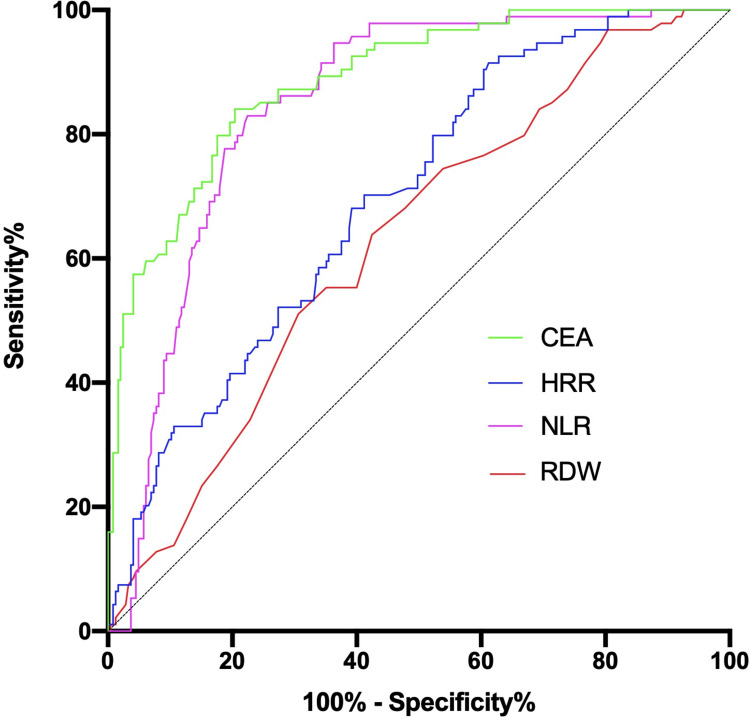
The ROC curves for RDW, NLR, HRR and CEA.Area under ROC curves were 0.629, 0.846, 0.696 and 0.887, respectively. P values were all <0.001. RDW red blood cell distribution width; NLR neutrophil-to-lymphocyte ratio; HRR hemoglobin-to-red blood cell distribution width ratio; CEA carcinoembryonic antigen; ROC receiver operating characteristic.